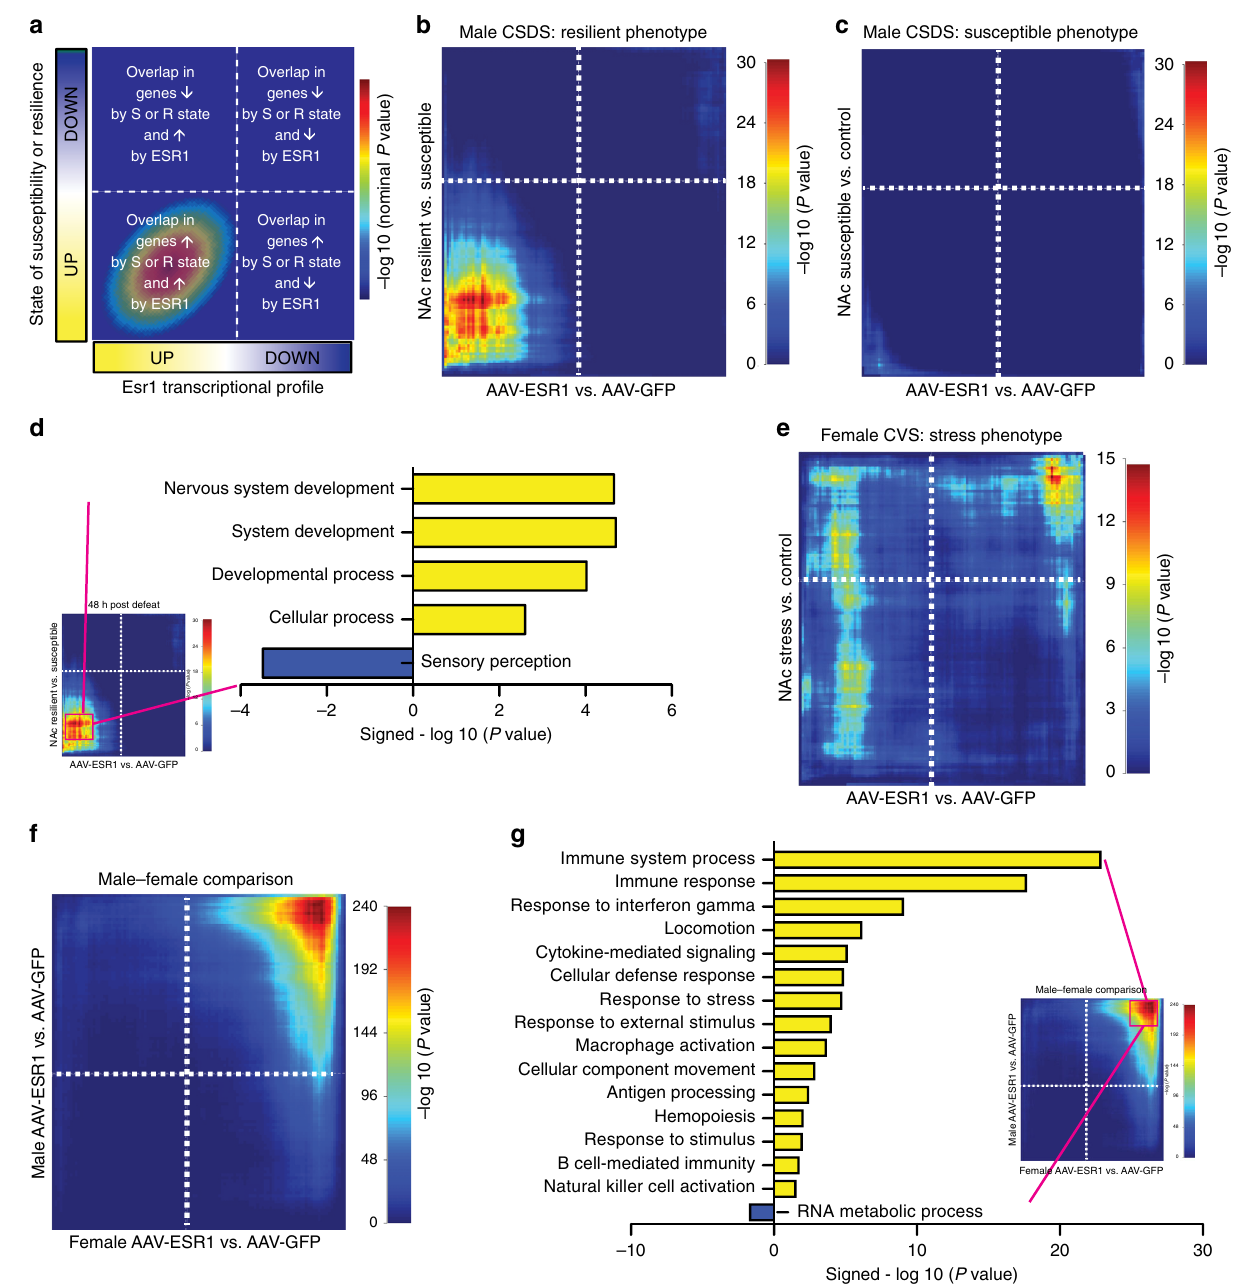
Fig. 5 ER α overexpression in NAc recapitulates the transcriptional signature of resilience in male mice. a Overview of RRHO. b The genes most strongly upregulated by ER α overexpression in the male NAc overlap with genes most strongly upregulated in this region of resilient mice after CSDS. c The male transcriptional signature of ER α overexpression is distinct from the transcriptional signature of CSDS susceptibility. d GO analysis of transcripts co- upregulated by ER α overexpression and the resilient phenotype after CSDS shows a positive enrichment for genes implicated in nervous system development and a negative enrichment for sensory perception genes. e ER α overexpression in the NAc of female mice induces a transcriptional pattern distinct from that induced by CVS. f ER α overexpression in male and female mice shows an overlap only in the most strongly downregulated genes. Genes upregulated by ER α overexpression, or moderately regulated in either direction by ER α , do not overlap. g GO analysis of transcripts co-downregulated by ER α in males and females indicates positive enrichment with immune-associated functions and underrepresentation of RNA metabolic signi fi cantly (Fig. 5f). To determine the biological functions associated with the shared overlap in downregulated genes, we performed GO analysis on the 320 most signi fi cant RRHO- identi fi ed genes. Within this set, we found statistical over- representation of immune-related processes with an under- representation of terms related to RNA metabolism (Fig. 5g).